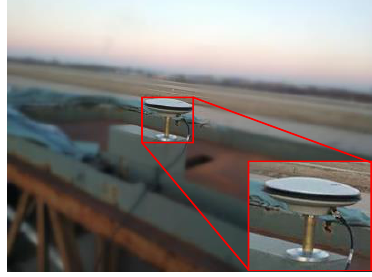
Figure 11. RTK GPS in the field.